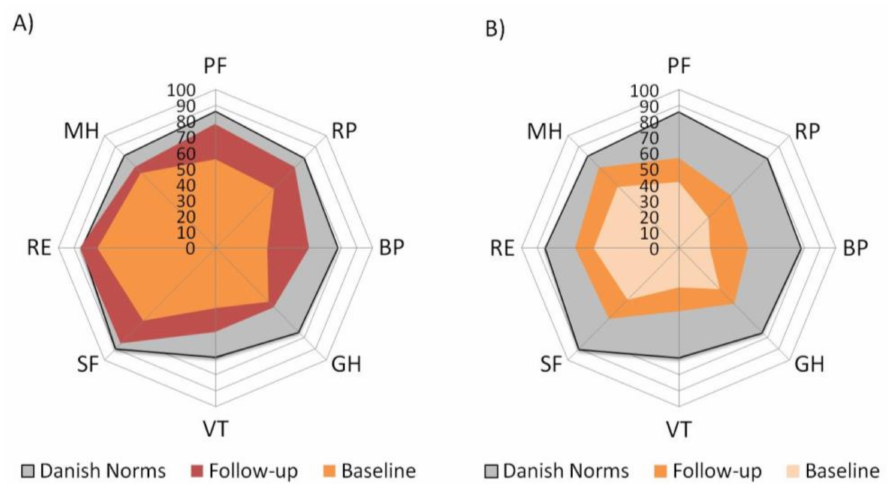
Figure 2. Mean SF-36 scores for Danish axSpA patients stratified by pain profiles. ( A ) axSpA patients classified as pure nociceptive pain (NcP) profile at baseline ( B ) axSpA patients classified as mixed pain (MP) profile. Mean SF-36 scores for Danish norms are also shown. PF, physical function; RP, role physical; BP, bodily pain; GH, general health; VT, vitality; SF, social functioning; RE, role emotional; MH, mental